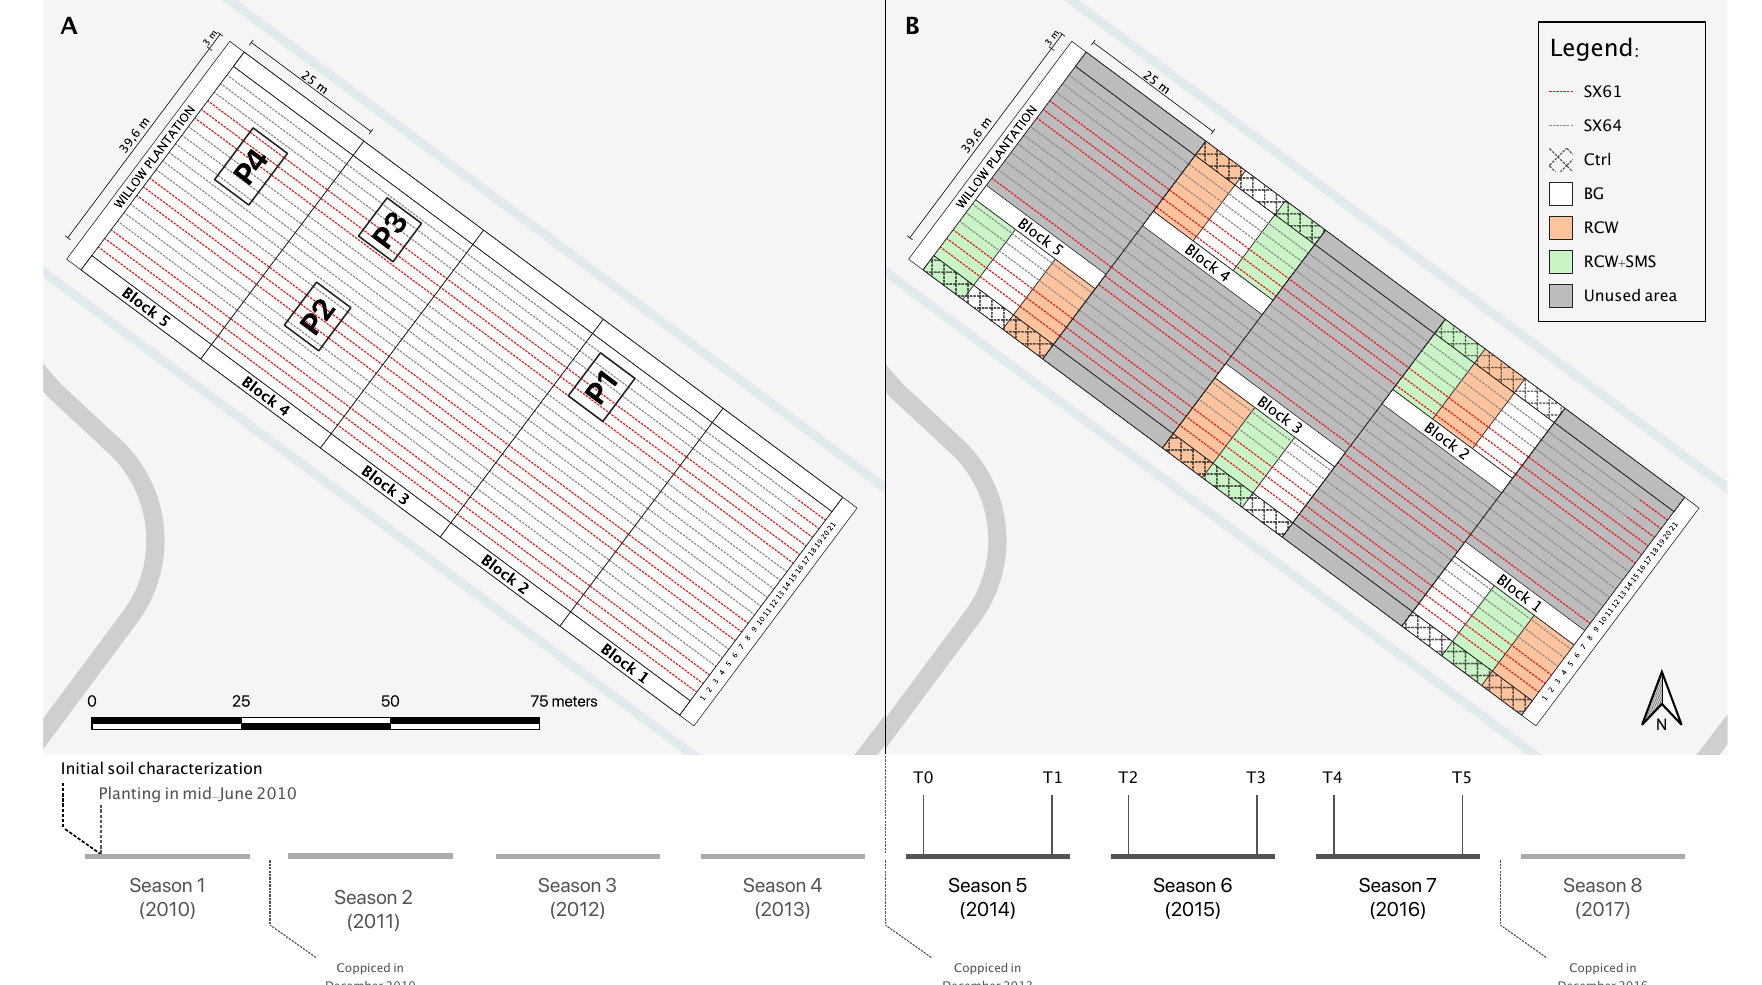
Figure 2. Evolution of the experimental design over time, including growth seasons, sampling times and coppicing times. ( A ) Experimental design of the first experimental phase, referred to as the GERLED site in Guidi et al. [55]. P1, P2, P3 and P4 were the sampling plots in their study; ( B ) Experimental design of the current experiment. T0 to T5 are the moments corresponding to the soil sampling. Adapted from Guidi et al.